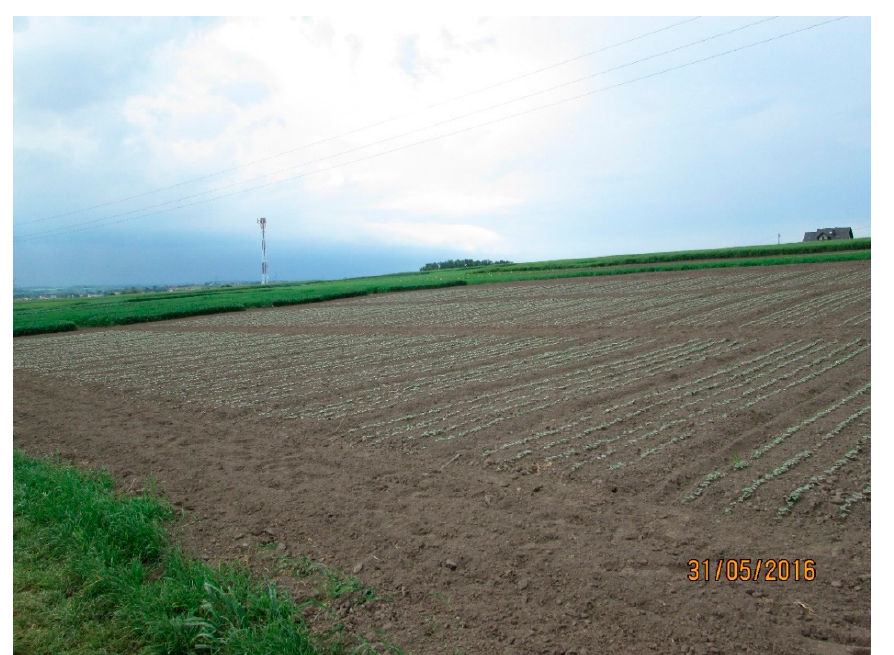
Figure A2. The experiment with the common buckwheat (BBCH